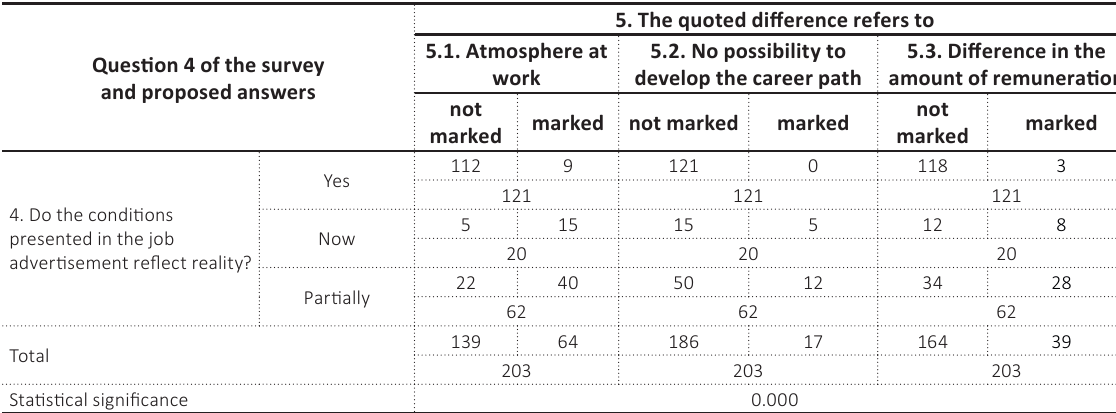
Table 4. Analysis of answers to questions 4 and 5 of the survey